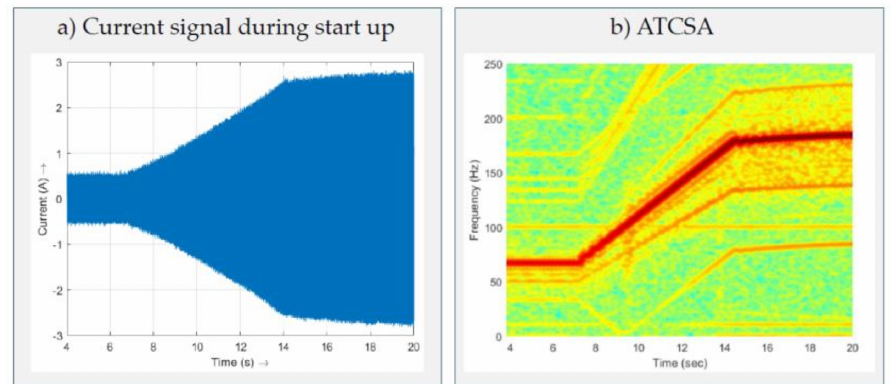
Figure 3. Implementation of the time-frequency transformation; ( a ) current signal during start-up; ( b )